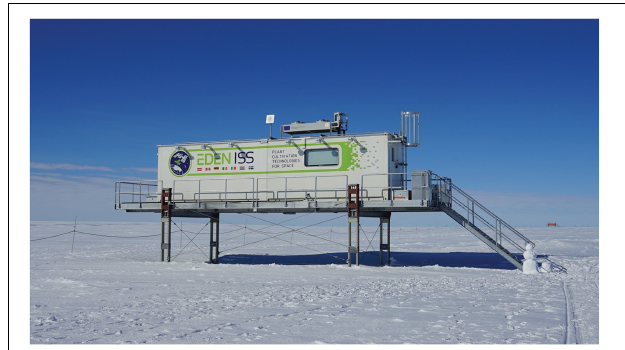
FIGURE 1 | The EDEN ISS Mobile Test Facility in Antarctica around 400 m south of the German Neumayer Station III.